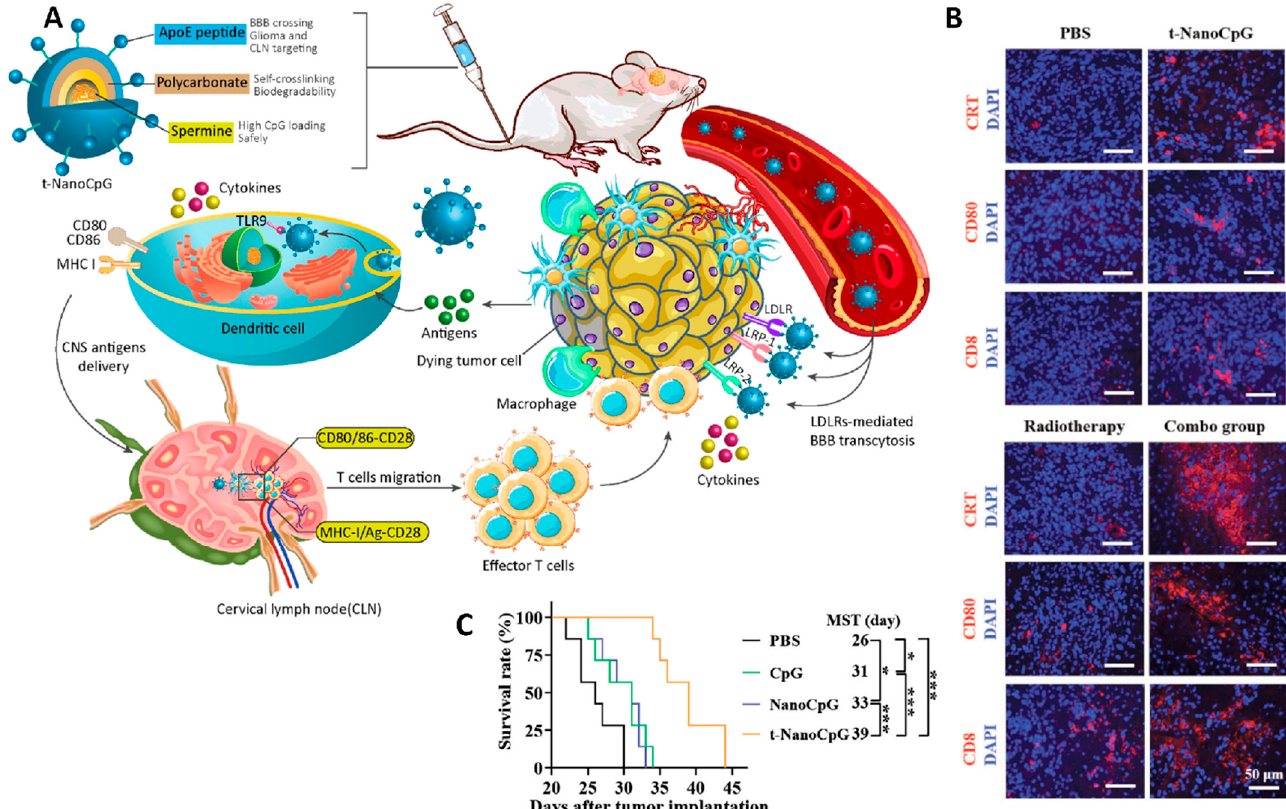
Figure 7. ( A ) Schematic representation of the intravenous brain delivery of a smartly targeted ApoE- functionalized polymersome CpG ODN nanoformulation for the immunotherapy treatment of GBM in mice. ( B ) The results of immunohistochemical staining of the tumor section of the brain were treated with different formulations. Combined immunotherapy and radiotherapy led to more ICD, as well as increased numbers of activated APCs and CD8 + T cells as compared to monotherapy. ( C ) Survival rate curve of mice treated with different formulations (* p < 0.05, and *** p < 0.001).